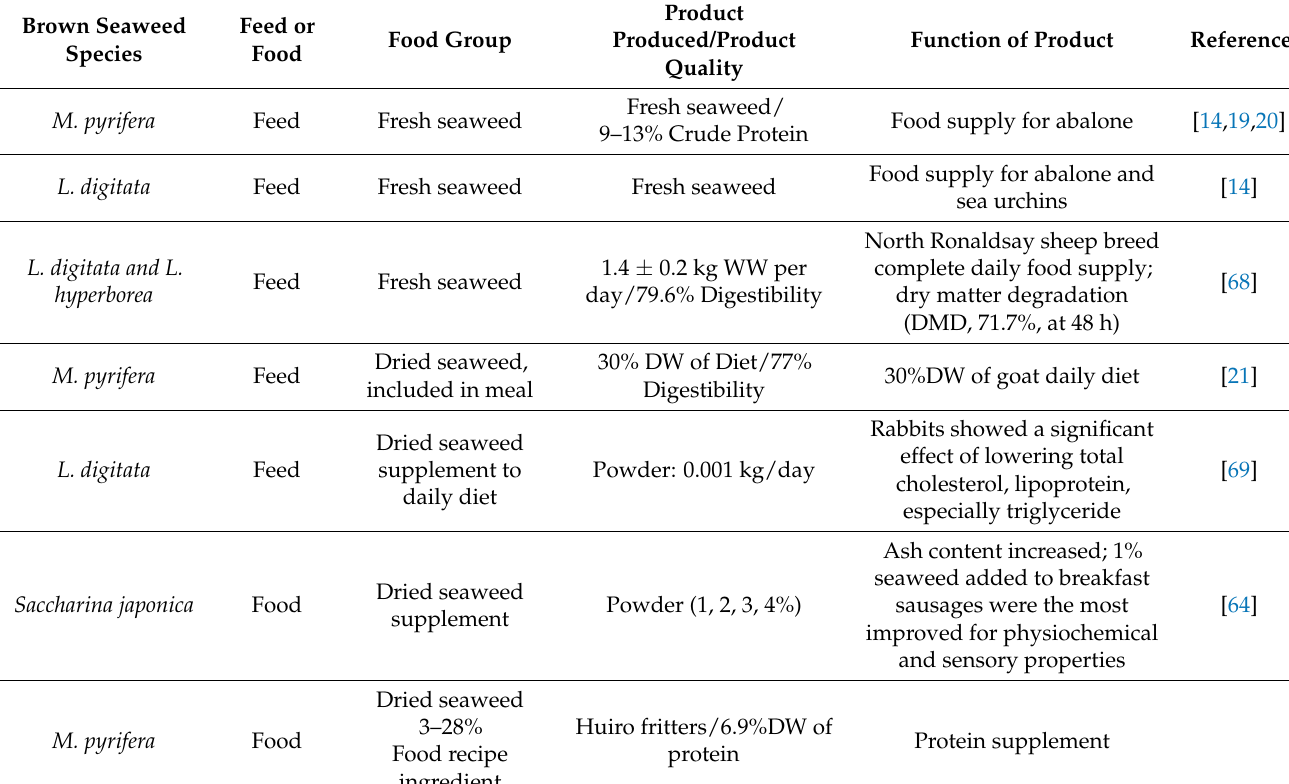
Table 1. Current commercial feed, food, and functional food products produced from Macrocystis pyrifera and Laminaria spp. Brown